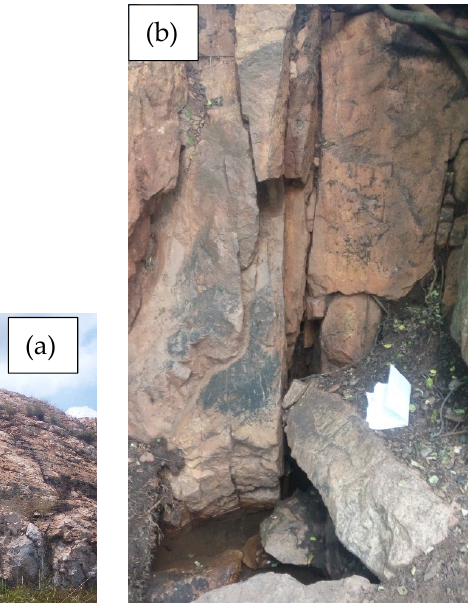
Figure 2. The quartzite on the southern boundary of the UCRB ( a ) and the fractured quartzite rocks that host the Albert Farm spring ( b